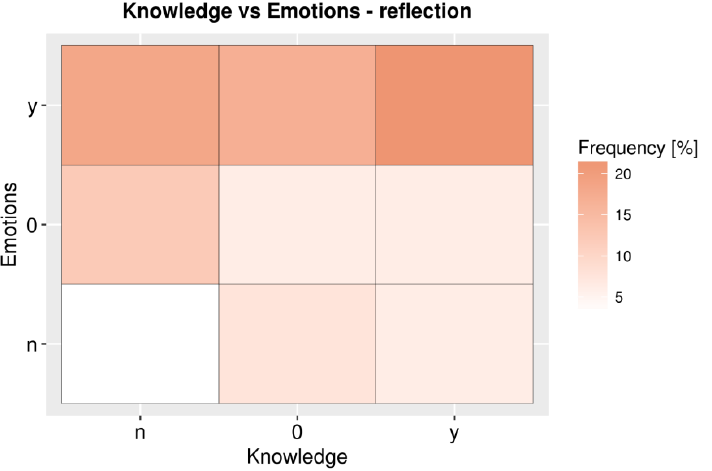
Figure 5. Frequency of responses compared between the knowledge and emotions dimensions—users with reflection (Y).